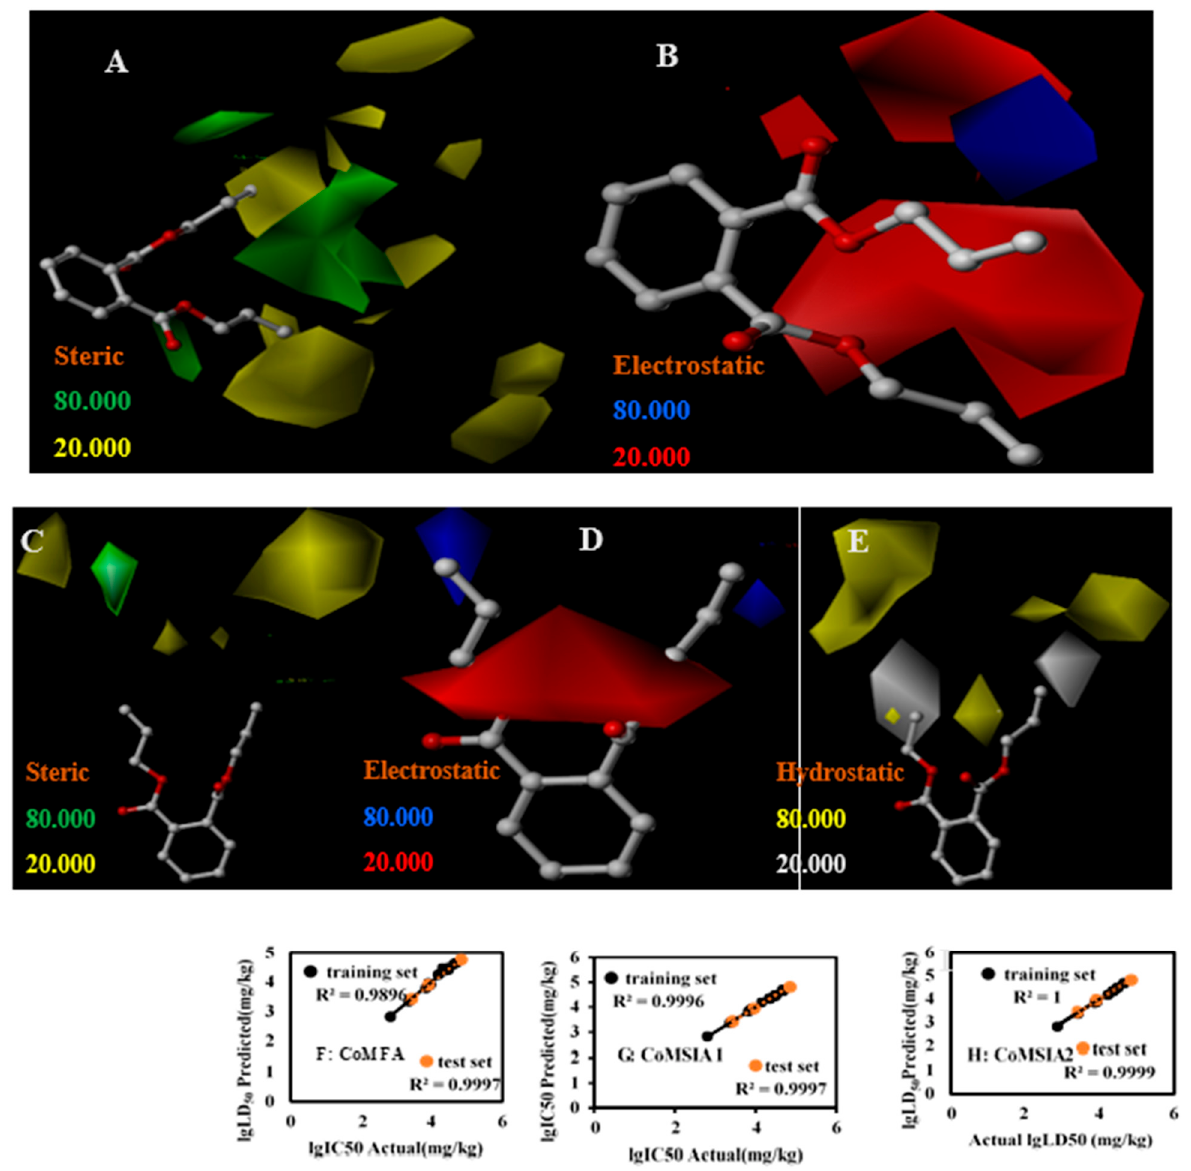
Figure 3. DAP’s three-dimensional contour maps of steric field ( A ), the electrostatic field ( B ) in the CoMFA model and steric field ( C ), the electrostatic field ( D ), hydrophobic field ( E ) in the CoMSIA2 model. The relation schema between predicted values and experimental values on PAEs’ lgLD50 (( F ): CoMFA; ( G ): CoMSIA1; ( H ): CoMSAI2). Structural superimposition of PAEs(I).